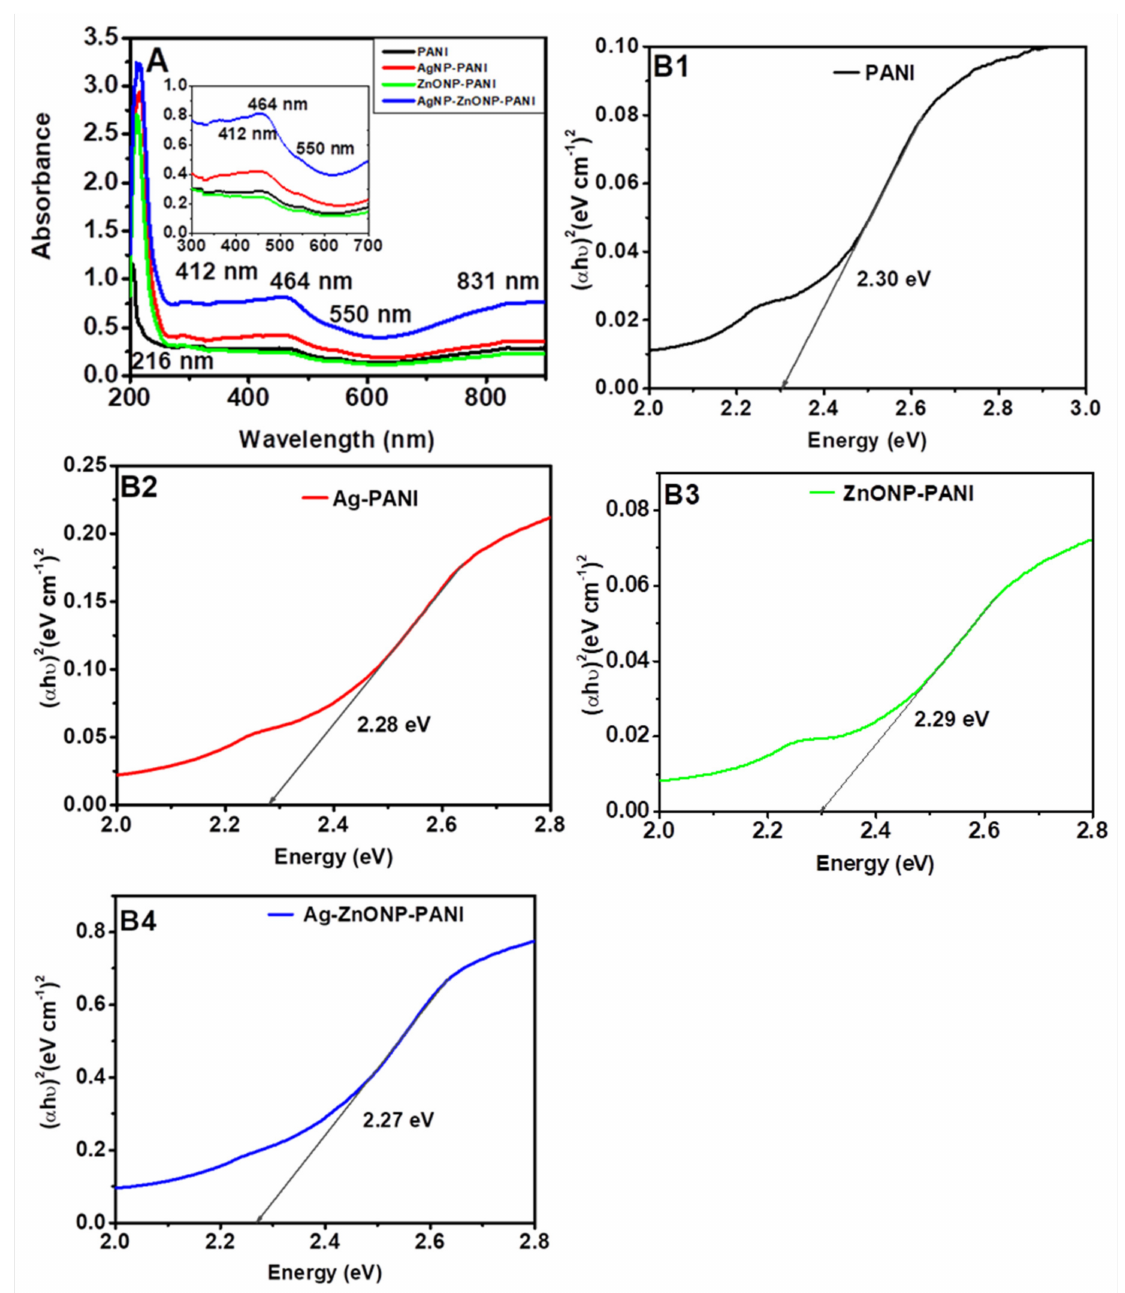
Figure 2. UV-Vis spectra ( A ) and Tauc plots ( B1 – B4 ) of materials for wavelengths 200–900 nm. ( A ) (insert) is the UV-Vis spectra for wavelengths 300–700 nm. Figure 2B1–B4 show the energy band gap energy values of 2.3 eV, 2.28 eV, 2.29 eV, and 2.27 eV associated with PANI (Figure 2B1), AgNP-PANI (Figure 2B2), ZnONP-PANI (Figure 2B3), and Ag–ZnONP-PANI (Figure 2B4), respectively. The obtained values are within the band gap energy range reported in previous studies for PANI (2.51–3.11 eV) [65–67], AgNP-PANI (2.07–2.37 eV) [37,65], and ZnONP-PANI (2.1–2.95 eV) [67–69]. The incorpora- tion of nanoparticles in PANI increases absorption, which leads to a reduction in the energy band gap due to charge transfer transitions, and hence increase in optical conductivity